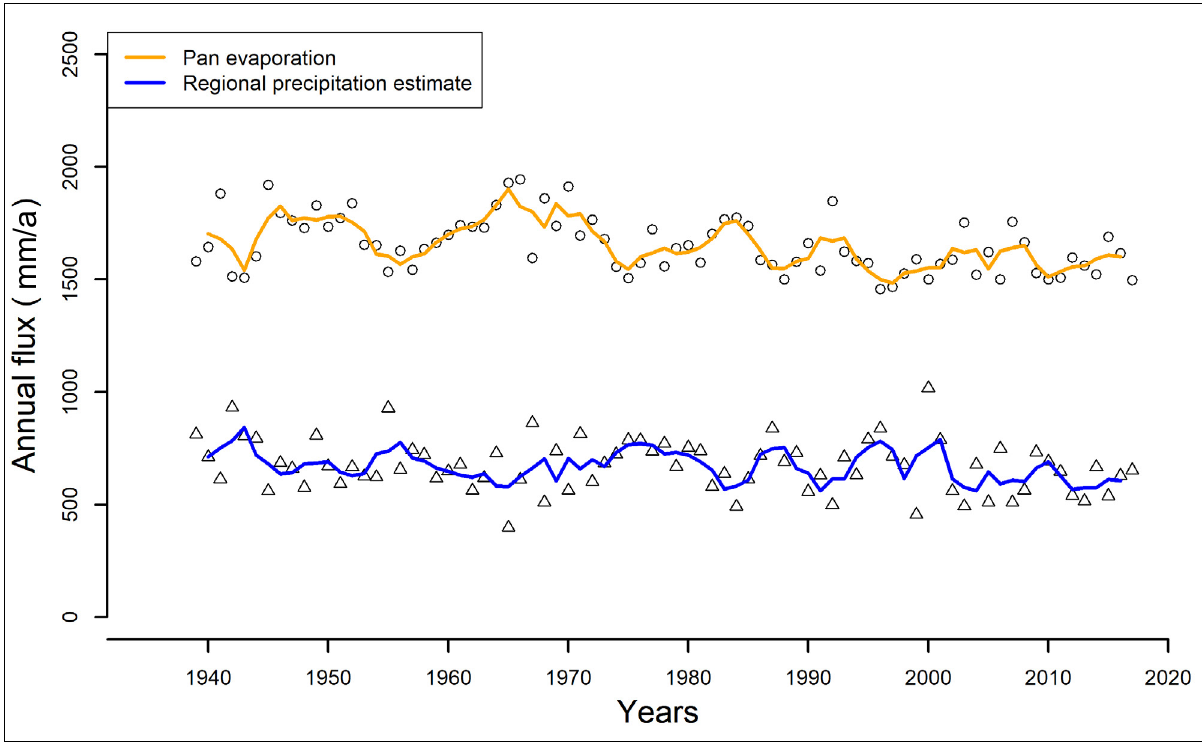
Figure 6: Annual Symons pan evaporation values (orange) for the Vaal Dam plotted against the CRU TS 4.03 precipitation data for the 0.5° gridded square for the same